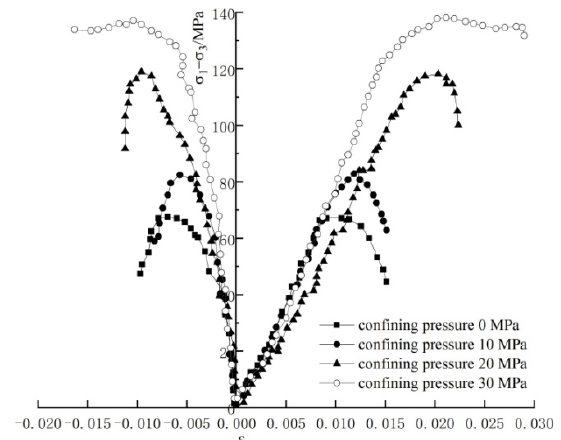
Figure 3. Stress–strain curves of sandstone during deformation under conventional triaxial compression.